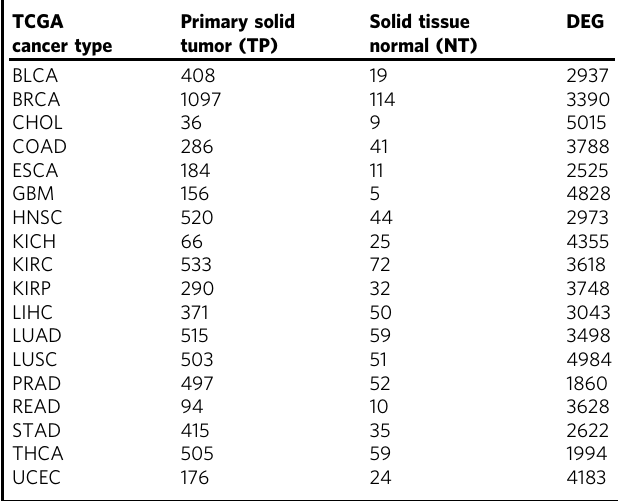
Table 2 Summary of TCGA RNA-seq samples and differentially expressed genes (DEGs), (tumor vs normal analysis) in 18 cancer